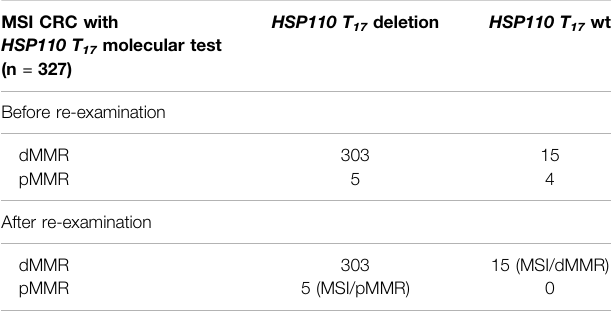
TABLE 3| Distribution of MMR status according to HSP110 T 17 molecular status.